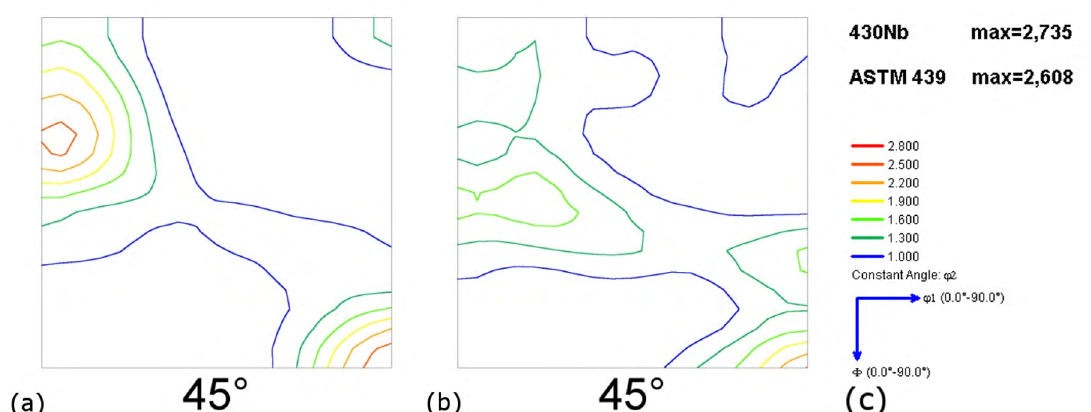
Figure 6. ODFs maps of hot rolled samples (HR). (a) 430Nb steel. (b) ASTM 439 steel. (c) levels. Constant sections of